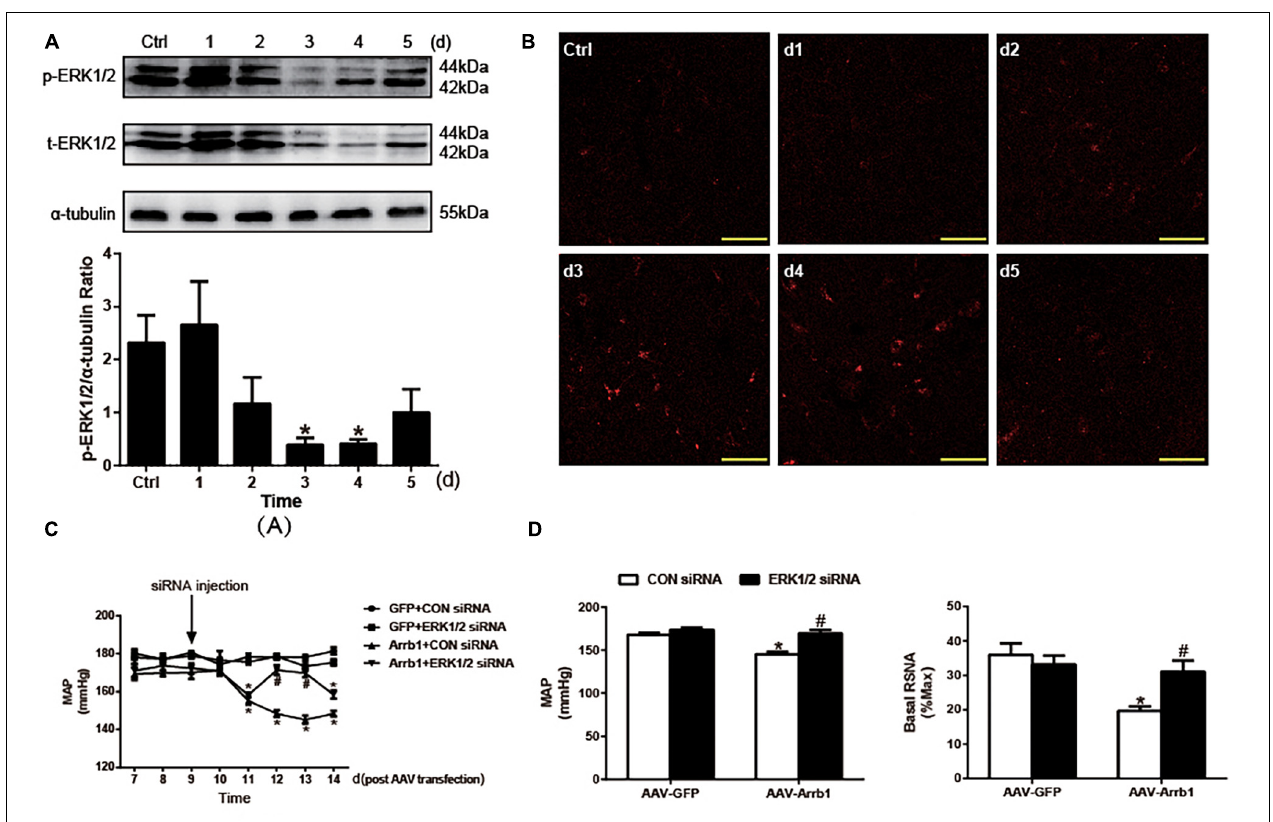
FIGURE 3 | Effects of knockdown of ERK1/2 in the RVLM on the β -arrestin1-induced changes in BP and RSNA. (A) Representative gel bands (top) and quantification data (bottom) show the changes in phosphorylated and total ERK1/2 after treatment of ERK1/2 siRNA in the RVLM. n = 4 per group. * P < 0.05 vs. Ctrl. (B) Confocal microscopy photographs consecutively represent the potency and stability of siRNA-Cy3 (red fluorescence) in the RVLM from day 1 to day 5. (C) Levels of BP in the conscious groups (GFP + CON siRNA, GFP + ERK1/2 siRNA, Arrb1 + CON siRNA, and Arrb1 + ERK1/2 siRNA). The treatment of siRNA injection into the RVLM of SHRs was performed at day 9 post AAV transfection. n = 5 per group. * P < 0.05 vs. day 7 in the corresponding group; # P < 0.05 vs. CON siRNA. (D) Changes in BP (left) and basal RSNA (right) of anaesthetized SHRs in response to siRNA injections. n = 5 per group. * P < 0.05 vs. AAV-GFP; # P < 0.05 vs. CON siRNA. MAP, mean arterial pressure; Ctrl, rats that received transfection reagent without siRNA; ERK1/2, extracellular regulated kinase; RVLM, rostral ventrolateral medulla; BP, blood pressure; RSNA, renal sympathetic nerve activity; siRNA, small interfering RNA; GFP, green fluorescent protein; SHR, spontaneously hypertensive rat; AAV, adeno-associated